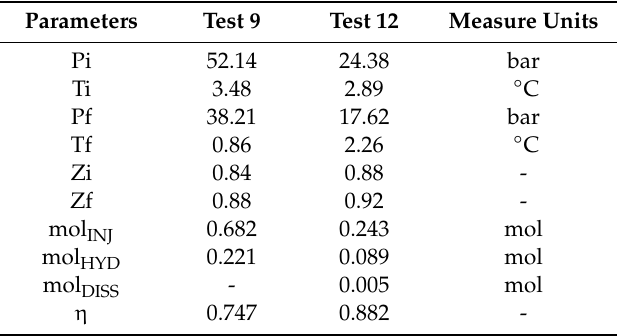
Table 6. Parameters related to Test 9 (with CH 4 ) and Test 12 (with CO 2